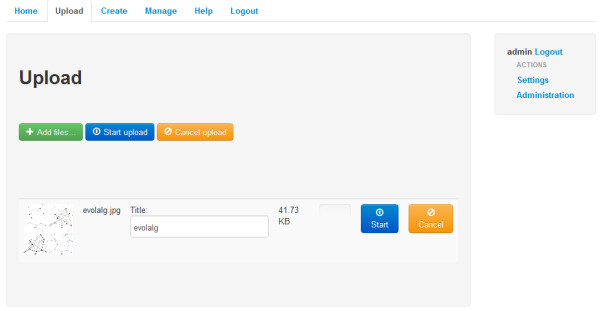
File upload screen.